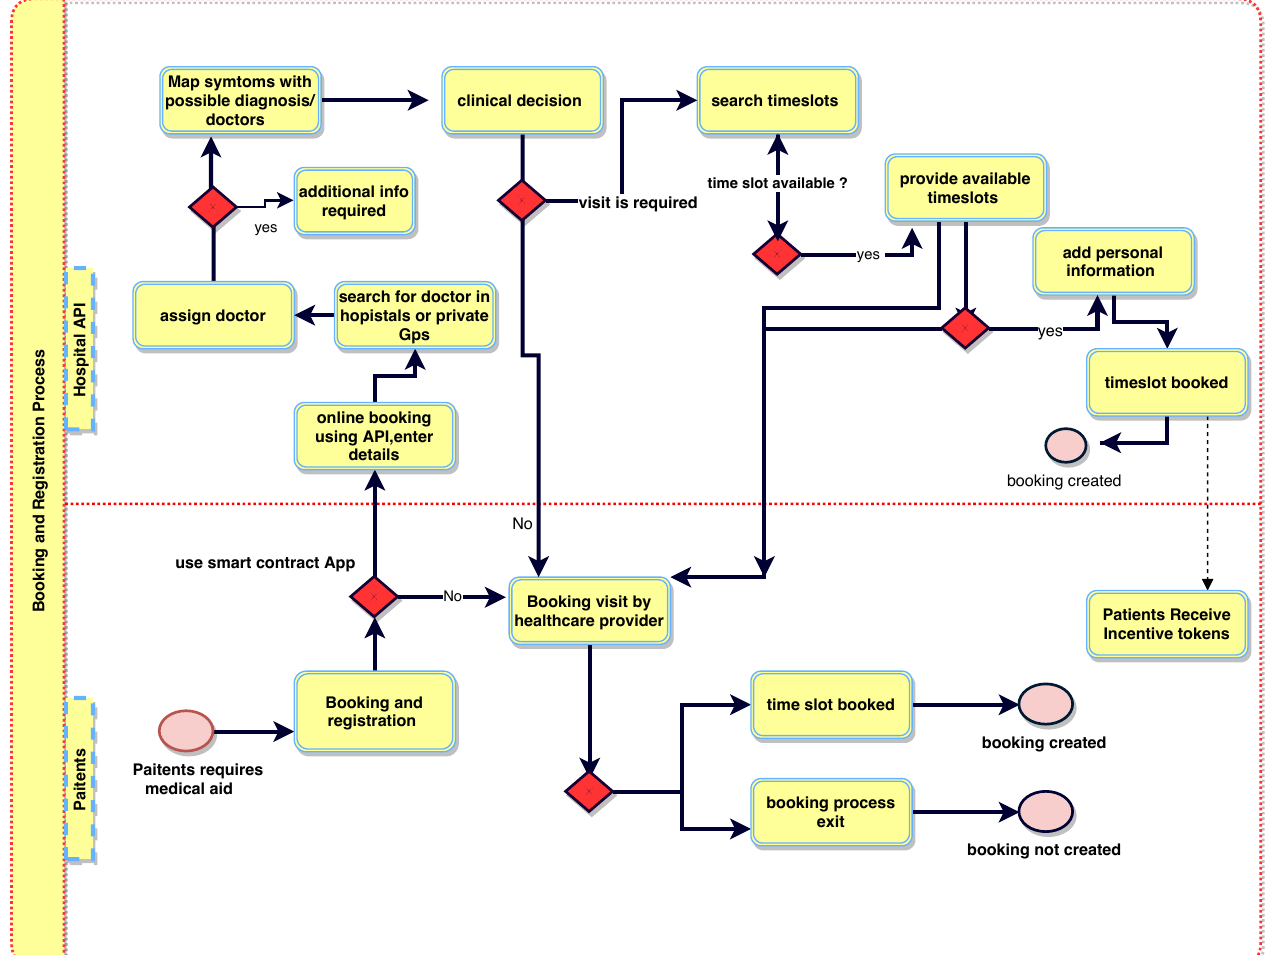
Figure 2. BlockPres booking and registration